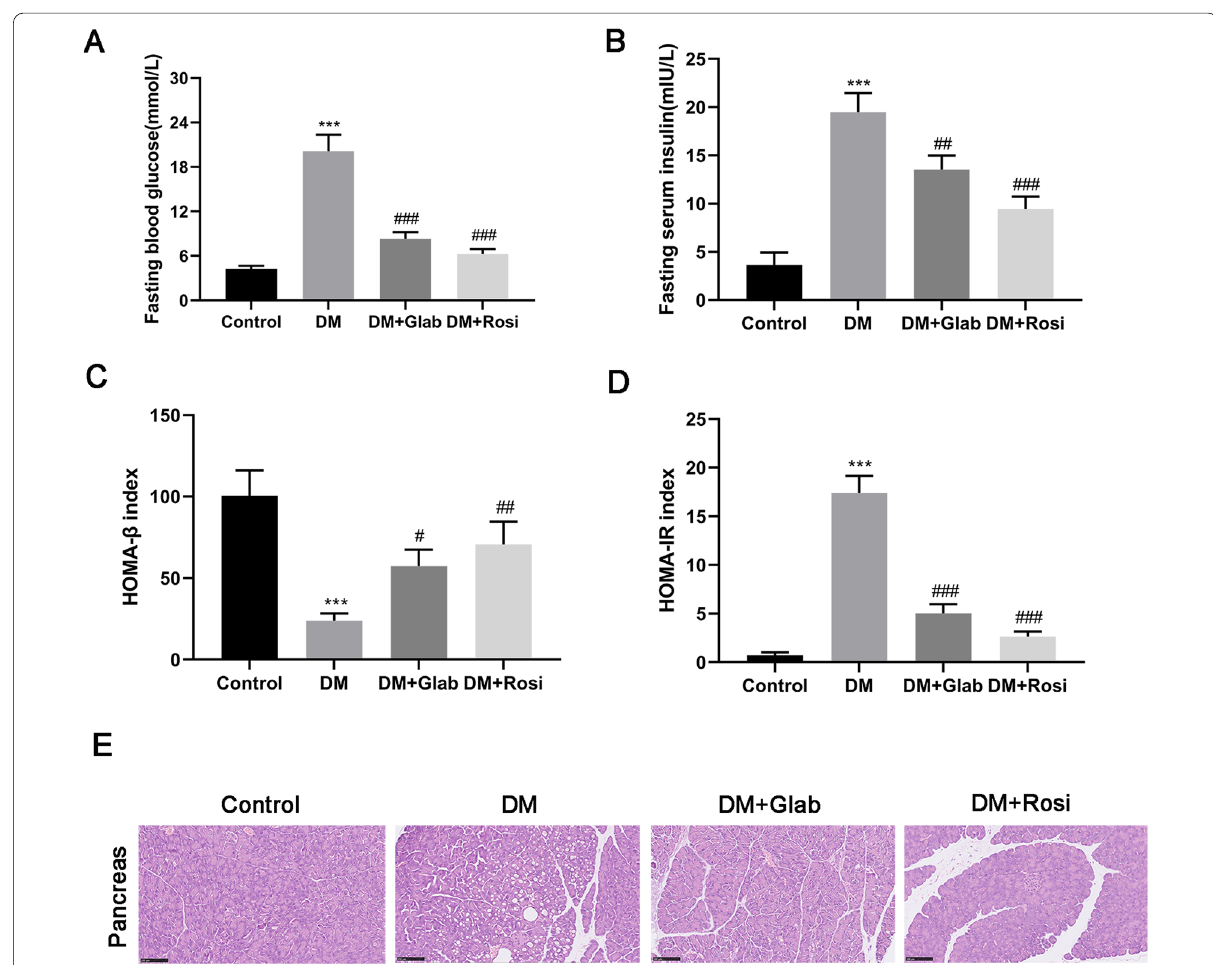
Fig. 3 Glab attenuates diabetic symptoms of DM rats. A Fasting blood glucose (FBG) level. B Fasting insulin (FINS) level. C HOMA-β index. D HOMA-insulin index. E H&E staining of pancreatic tissues (magnification